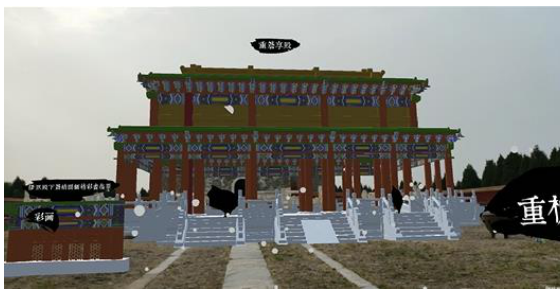
Figure 45. The structure of upper cornice is